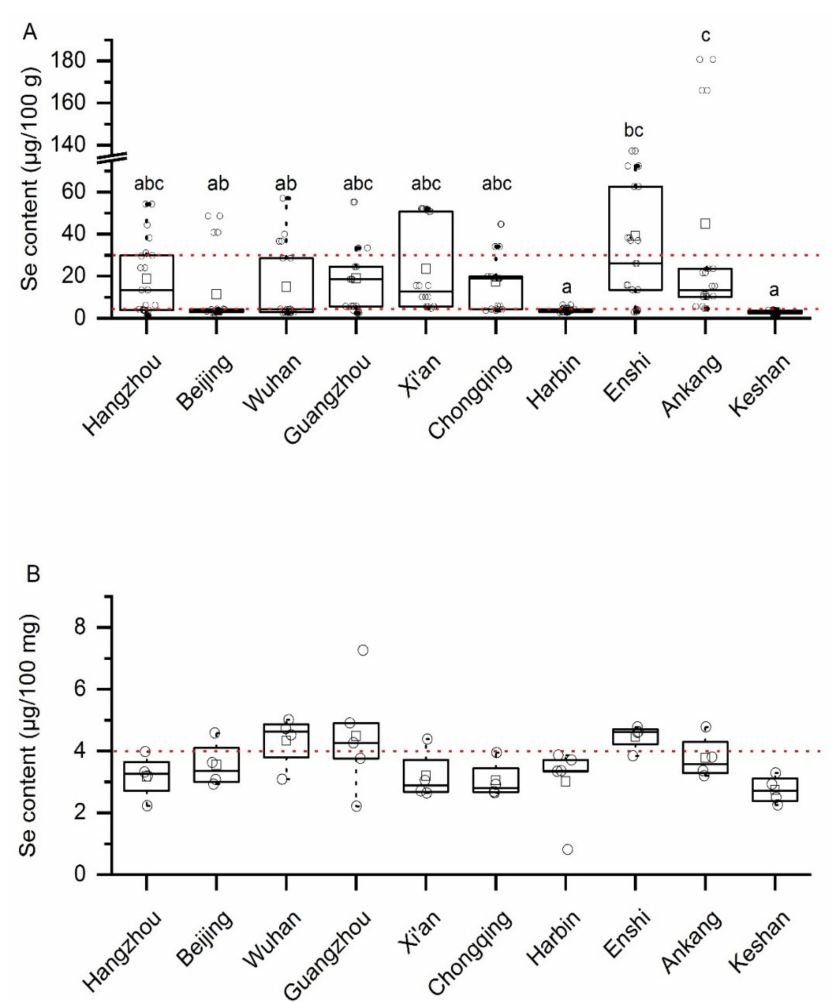
Figure 1. Box diagram of total selenium content in selenium-rich and common rice in 10 sampling areas. ( A ) Box diagram of selenium content in selenium-rich rice: the two red lines are 4 µ g / 100 g and 30 µ g / 100 g specified in the national standard of the People’s Republic of China (GB / T 22499–2008) of selenium-rich rice respectively. “a, b, c” represents the result of pairwise comparison of Tukey HSD, and the same letter indicates no significant di ff erence between the two groups; ( B ) Box diagram of selenium content in common rice: the red line is the lower limit of the standard GB / T